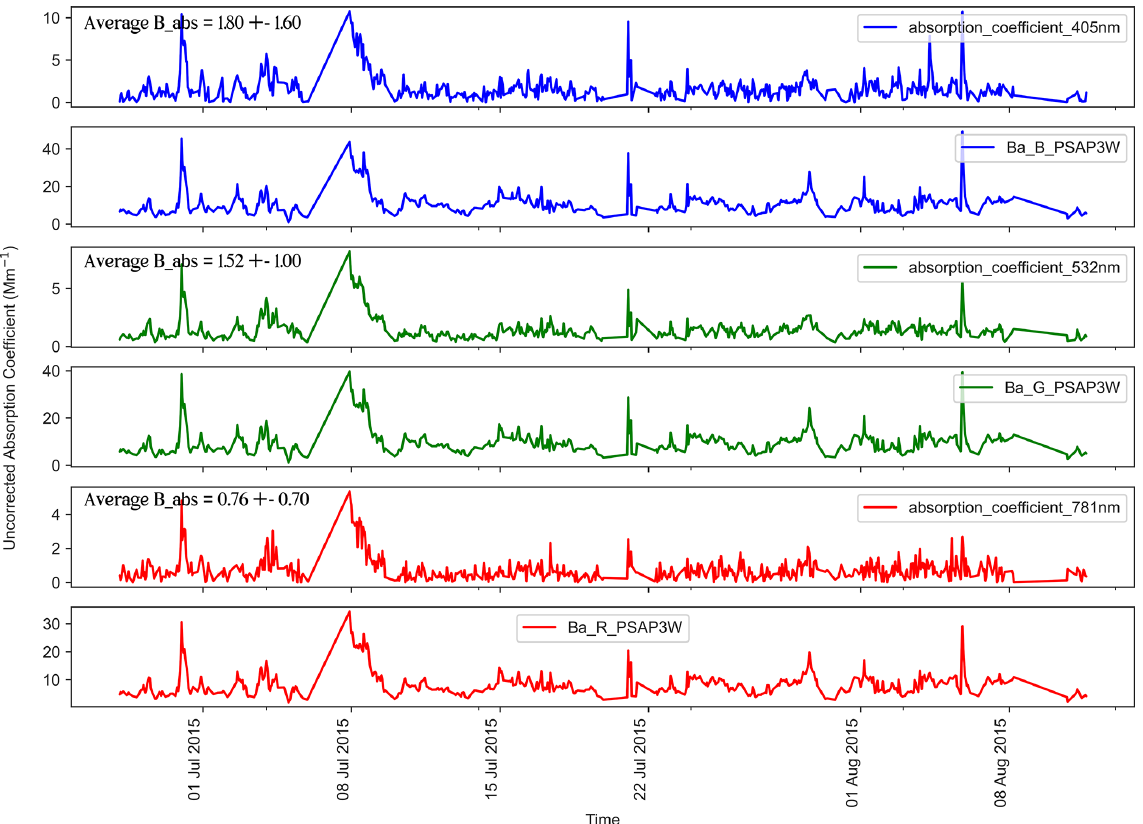
Figure A4. Time series data of uncorrected absorption coefficients as derived from the PSAP { B abs_uncorrected_PSAP } (at 467, 530, and 660nm) and PASS ( B abs ) (at 405, 532, and 781nm) instruments at the SGP observatory.